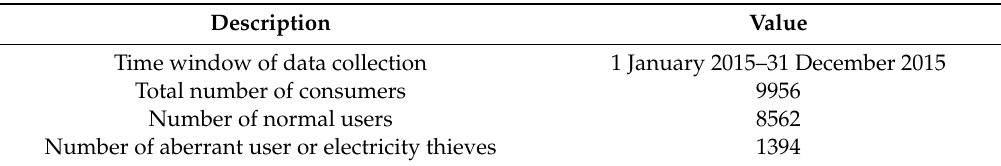
Table 1. Metadata information of the electricity theft dataset .